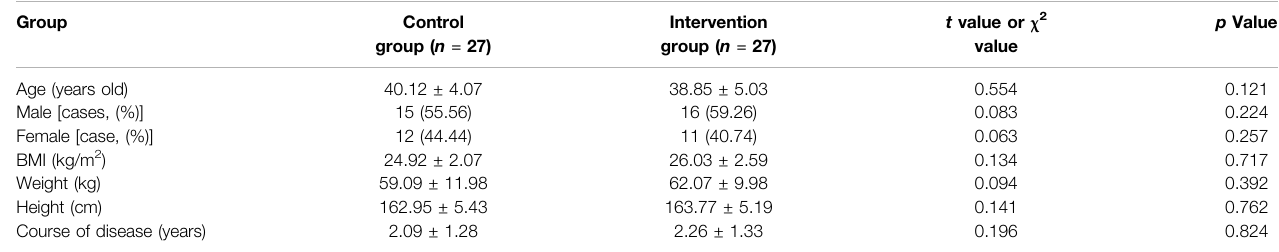
TABLE 2 | Comparison on basic data of patients from the two groups.